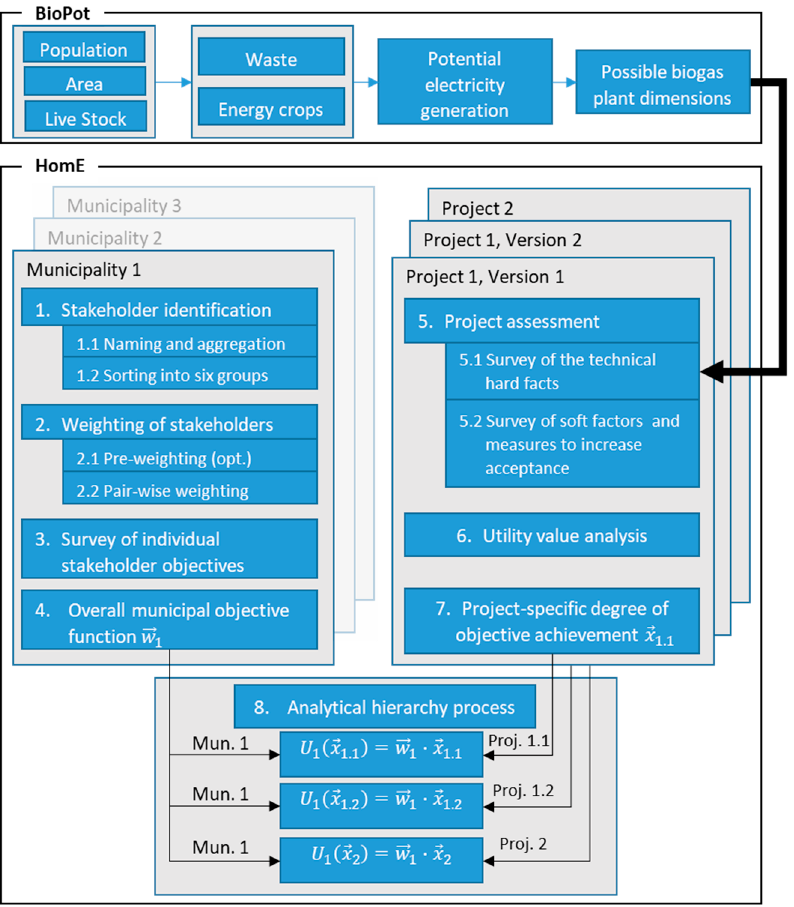
Figure 2. Process scheme of the presented methodology and models.